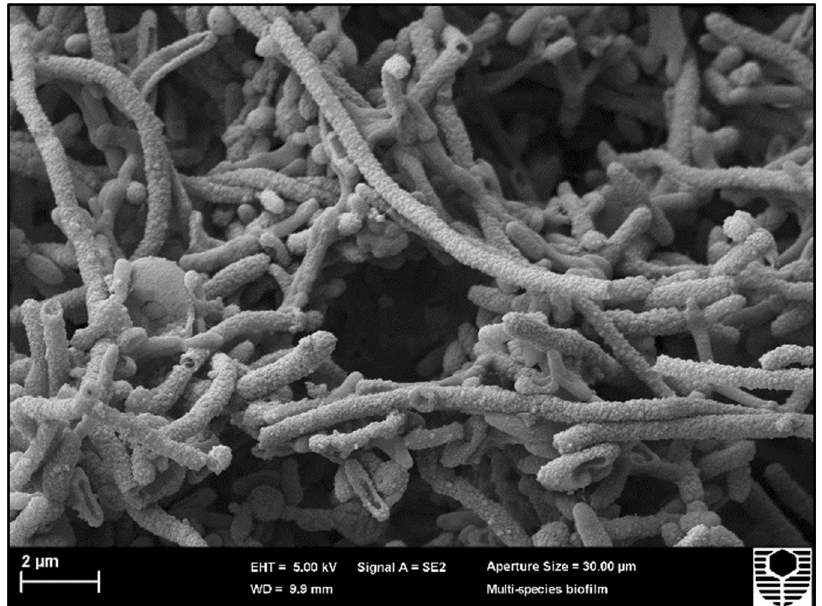
Fig. 4 SEM image of a marine consortium demonstrating close living arrangement and various cell morphologies. FESEM micrograph of a marine multi-species bio fi lm on carbon steel (AISI 1030) demonstrating the complexity and dense living arrangement of multi-species marine bio fi